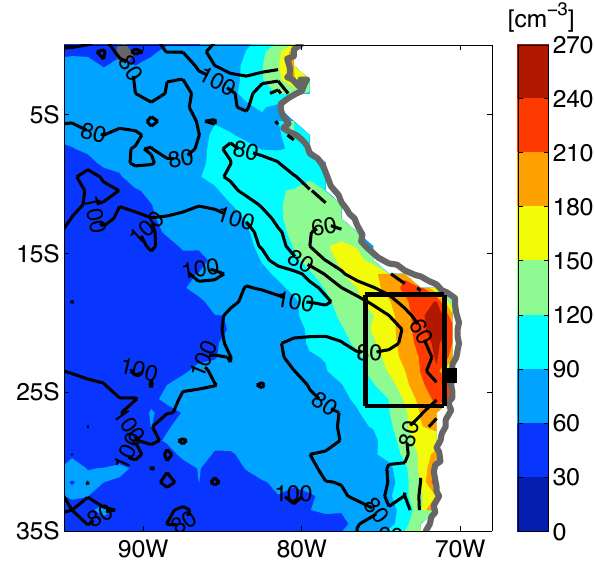
Fig. 1. Mean N d (#cm − 3 , colors) and LWP (gm − 2 , contours), Figure 1. Mean N d (# cm -3 , colors) and LWP (g m -2 , contours), based on October 2001 based on October 2001 and 2005–2008 Terra daytime MODIS level and 2005-2008 Terra daytime MODIS level 3 data. The box indicates the area over which 3 data. The box indicates the area over which the daily-mean N d were averaged and the black square indicates the daily-mean N d were averaged and the black square indicates Antofagasta.